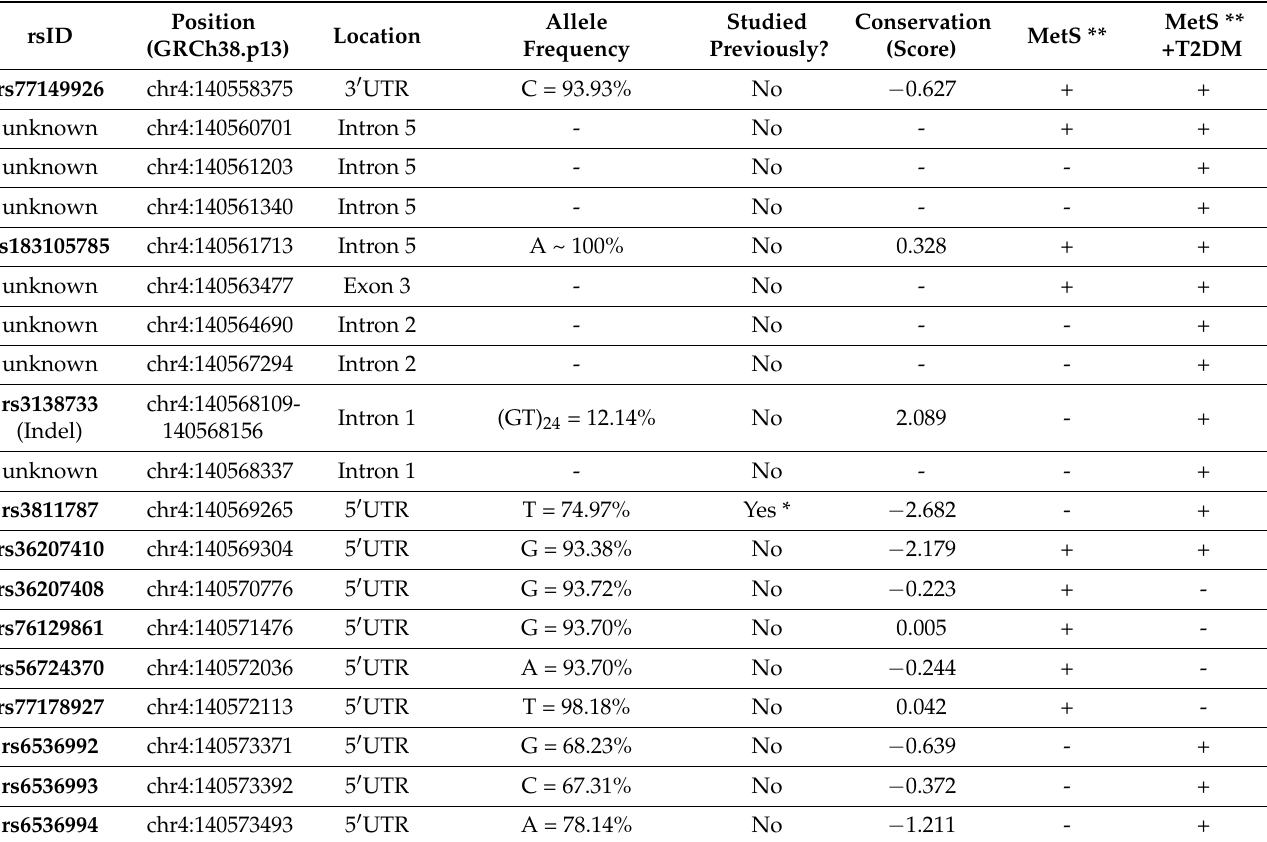
Table 4. Characteristics of selected UCP1 gene variants and variations differently distributed in the whole group of MetS patients and MetS with T2DM in comparison to